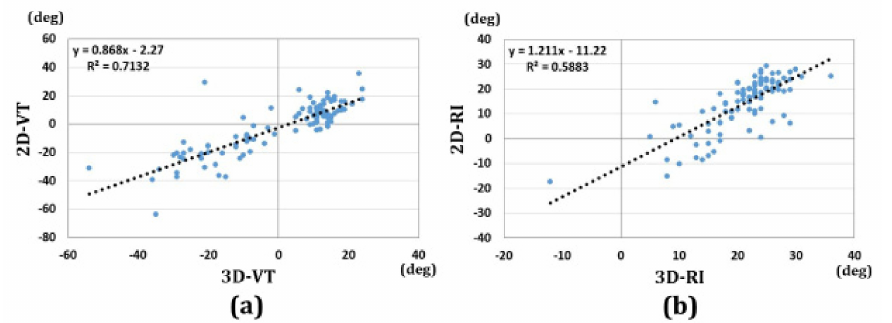
Figure 8. Results of the correlations between 2D and 3D measurements. ( a ) Results of the correlations between 2D-VT and 3D-VT. ( b ) Results of the correlations between 2D-RI and